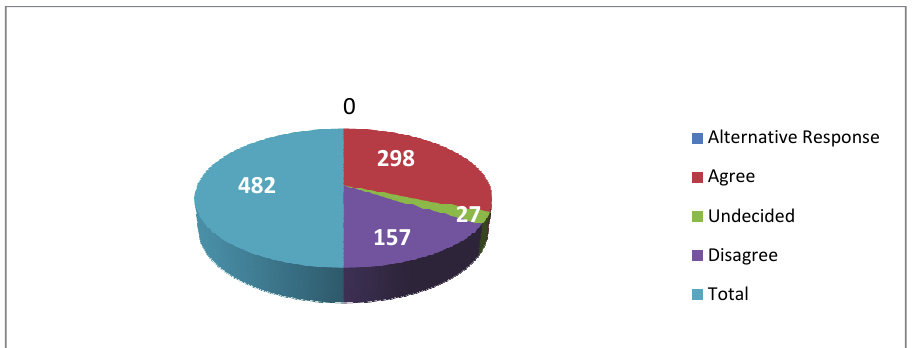
Pie Chart 10: Respondents’ Views on whether there is any relationship between lecturers’ incompetency and human capital